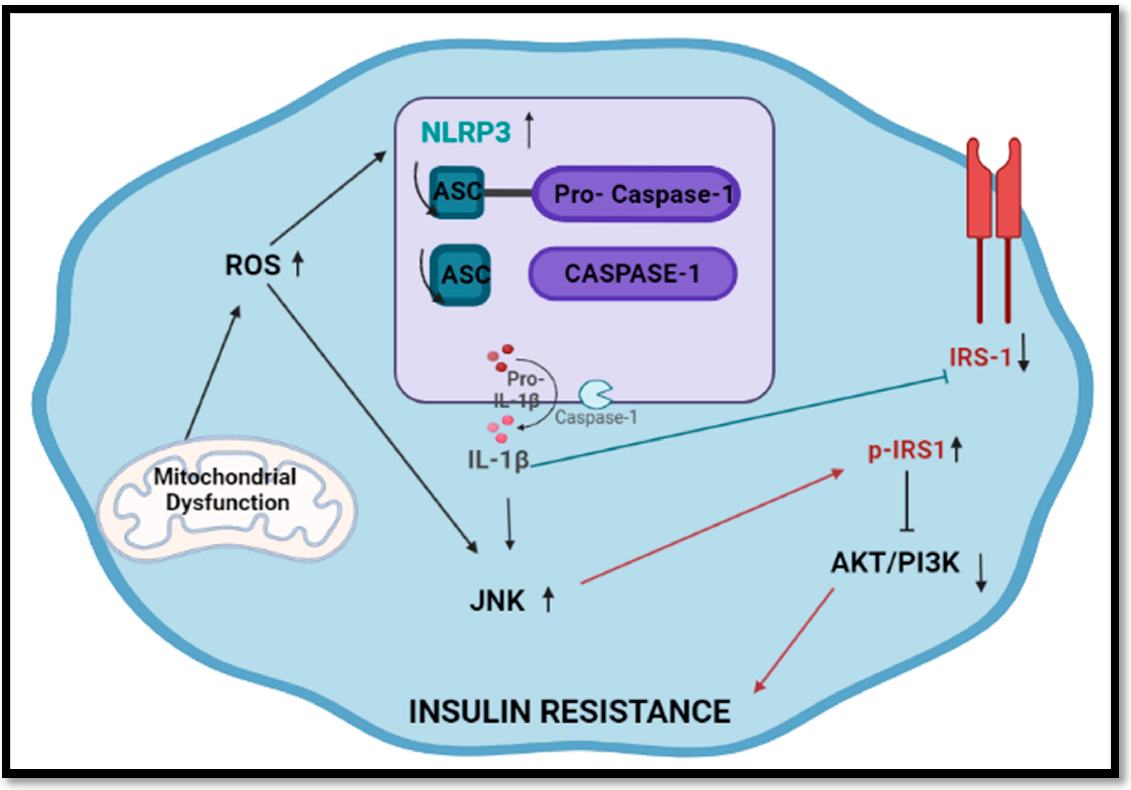
Figure 4. Inflammasome activation and subsequent occurrence of insulin resistance. Following activa- tion of inflammasomes via stress, IL-1 β allows for JNK activation leading to increases in p-IRS1 and aberration in AKT/PI3K signaling. Furthermore, decreased expression of IRS1 occurs.